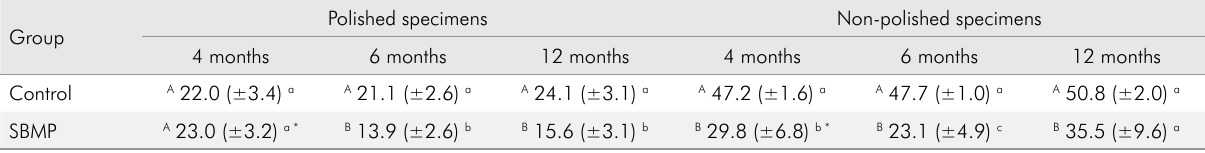
Table 1. Color change (Δ E * , mean ± standard deviation) of the polished and non-polished specimens after immersion in red wine at different time points.